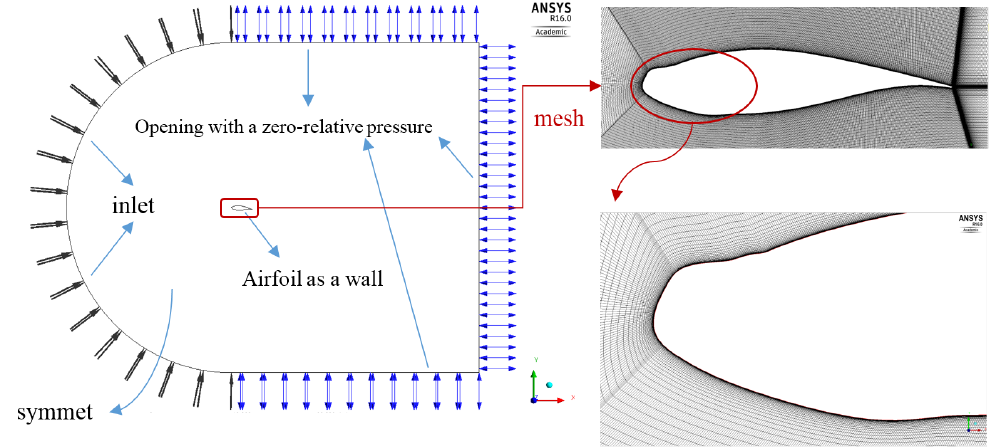
Figure 5. The model domain, boundary conditions and the mesh configuration around the